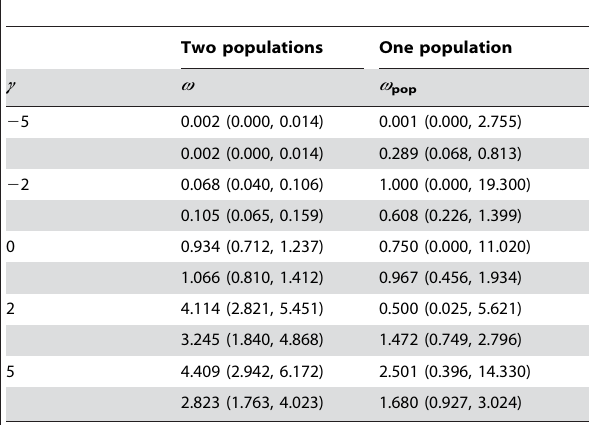
Table 1. The relationship between the scaled selection coefficient, c , and the dN/dS ratio as estimated by the PAML package from simulated